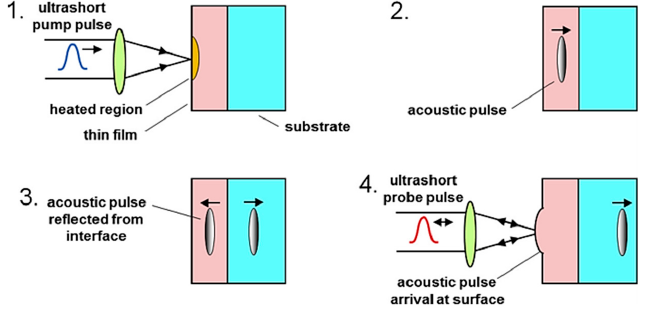
Figure 17. Elastic wave generation and sensing using ultrafast pump and probe laser pulses for detection of internal inhomogeneity (or the thickness of interface between thin film and substrate)